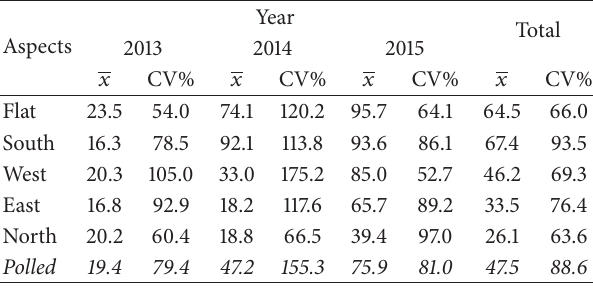
Table 1: Averages (𝑥) and coefficient of variation (CV%) for number of cones for the aspects and years.